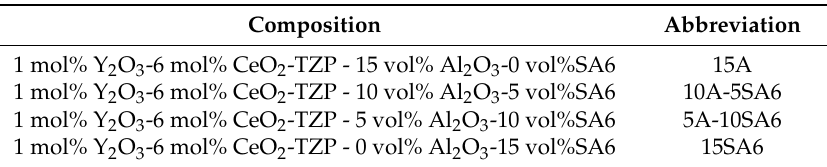
Table 1. Material compositions and